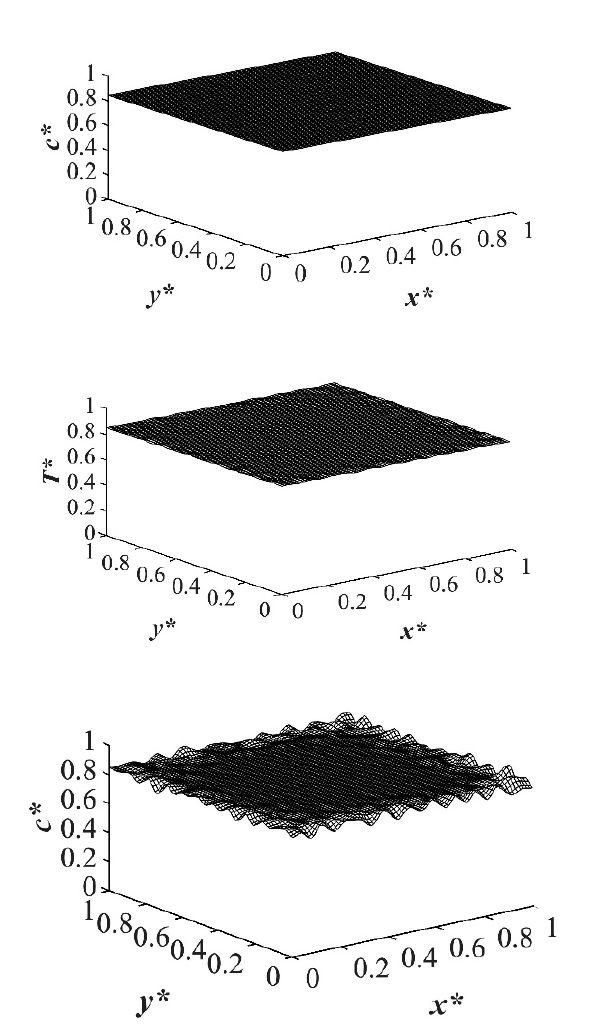
Figure 3. Spatial concentration ( left column) and temperature ( right column) profiles for the off- critical quench to c * = 0.85 at t * = 3.03 × 10 − 5 for three different quench depths of ( a ) T * q1 = 1.0, ( b ) T * q2 = 0.99 ( c ) T * q3 = 0.97.